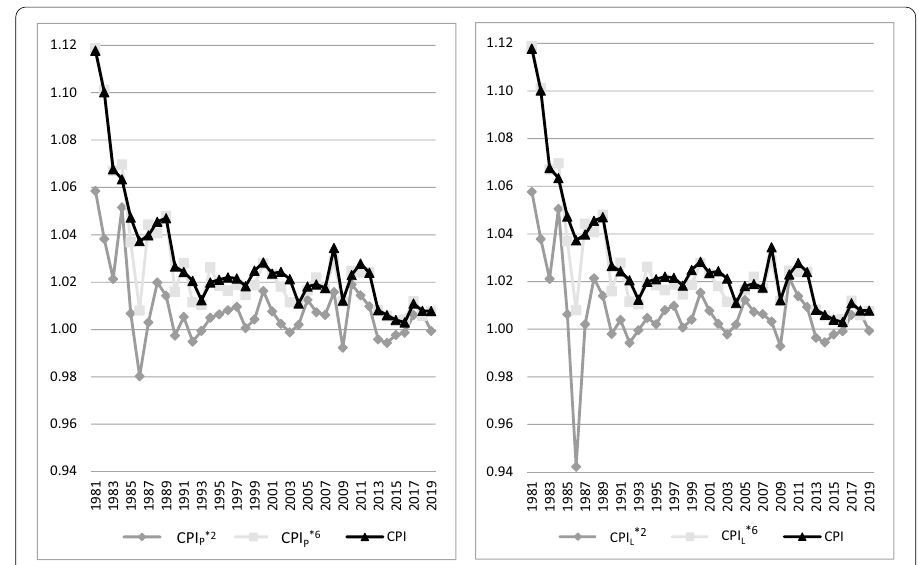
Fig. 2 Input–output pass-through of import prices into CPI (CPI* 2 ) versus input–output CPI (CPI* 6 ) and actual CPI ( based on Paasche [left] and Laspeyres [right] formula ). Source: own calculations based on Statistics Denmark